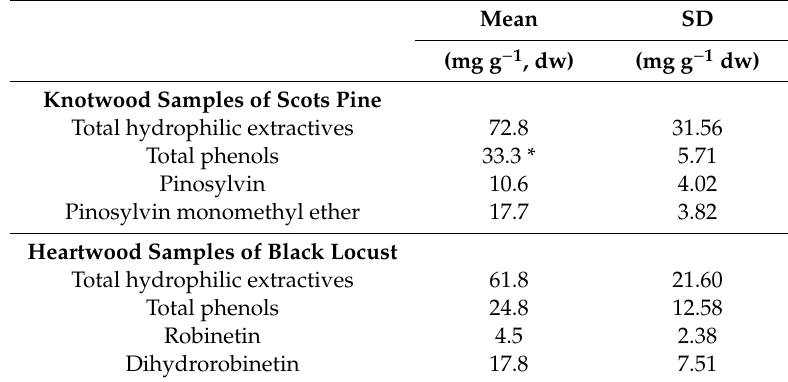
Table 1. Average amounts of extractives gained from individual knotwood samples of Scots pine ( Pinus sylvestris ) and heartwood samples of black locust ( Robinia pseudoacacia ). Results are expressed in milligrams of extracted compounds per gram of dried wood (mg g − 1 , dw). Mean SD (mg g − 1 , dw) (mg g − 1 dw) Knotwood Samples of Scots Pine Total hydrophilic